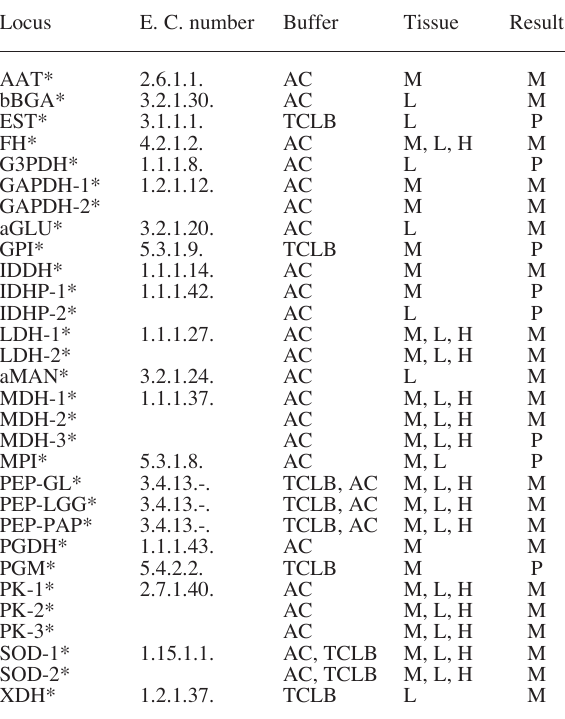
T ABLE 2. – Summary of enzymes studied for Coryphaena hippurus with locus abbreviation, Enzyme Commission number (E. C. number), best buffer and tissue used and